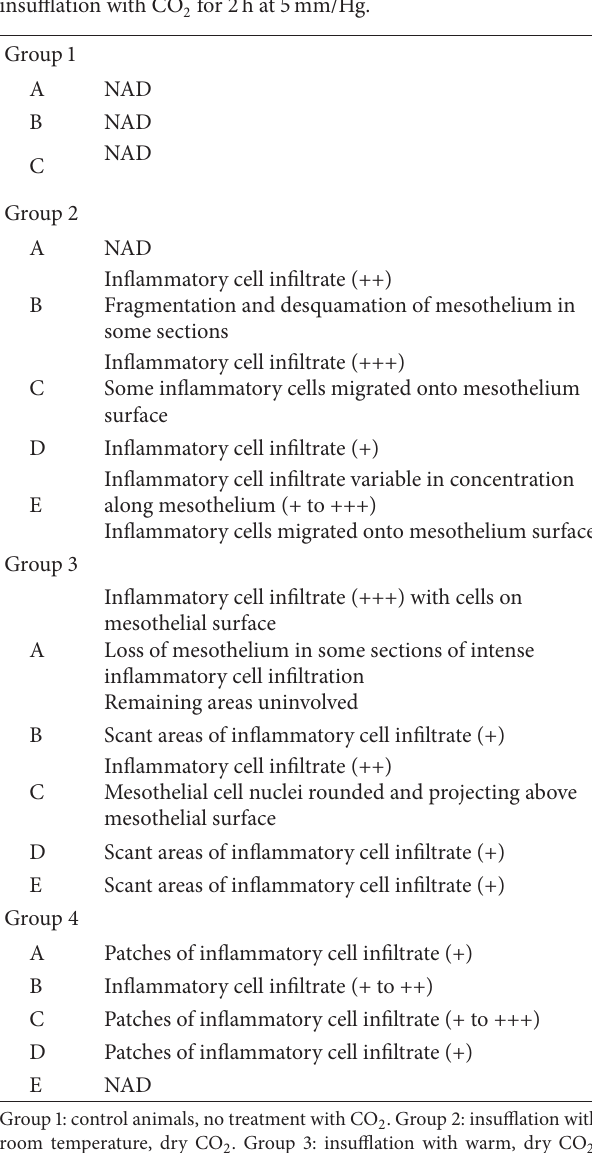
Table 1: Summary of light microscopy (LM) observations 12 h after for 2h at 5 insufflation with CO 2